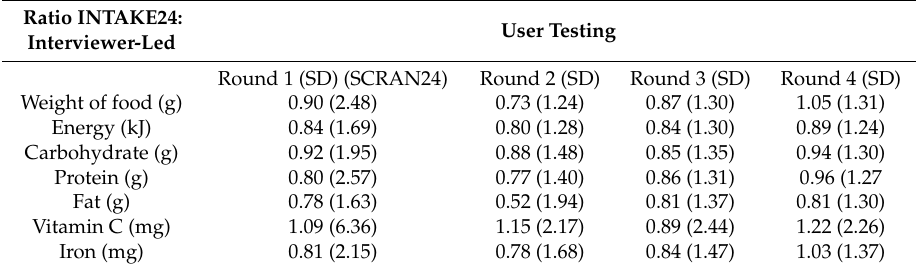
Table 2. Agreement between INTAKE24 and interviewer-led recalls at all four stages of testing. Ratio INTAKE24: